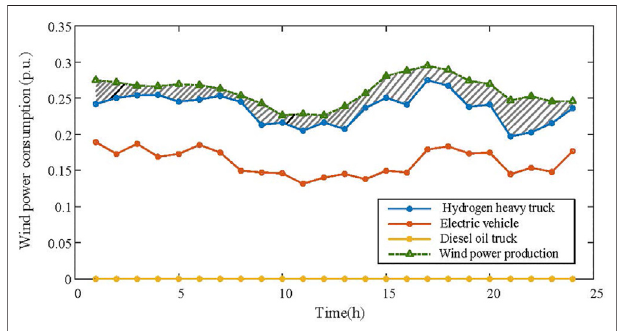
FIGURE 8 | Comparison of trucks consuming wind power.